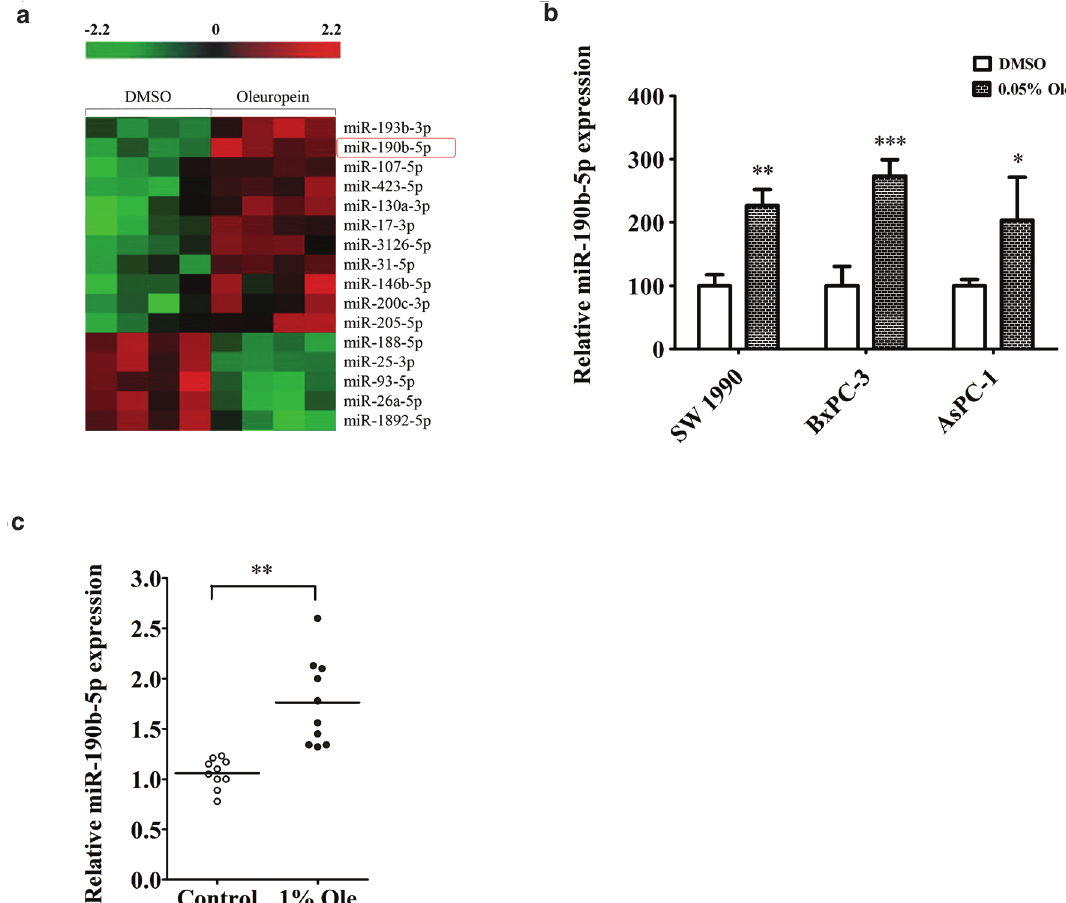
Fig. 3. Ole induces miR-190b-5p in vitro and in vivo . (a) Hierarchical clustering of selected miRNAs expression regulated by Ole. The SW 1990 ( n = 4, each group) was treated with 0.05% Ole or DMSO for 48 h. The miRNAs were harvested and subjected to GeneChip miRNA 2.0 Array study. (b) Realtime PCR analysis of miR-190b-5p induction by Ole. SW 1990, BxPC-3, and AsPC-1 were treated with 0.05% Ole or DMSO for 48 h. The fold induction of miR-190b-5p was determined by real-time PCR. (c) MiR-190b-5p expression levels in pancreatic tumors harvested from KPC mice. Control group received normal drinking water. Treatment group received 1% Ole in drinking water. The data were presented as means ± SD of three independent experiments (* P < 0.05, ** P < 0.01, and *** P < 0.001 as compared with